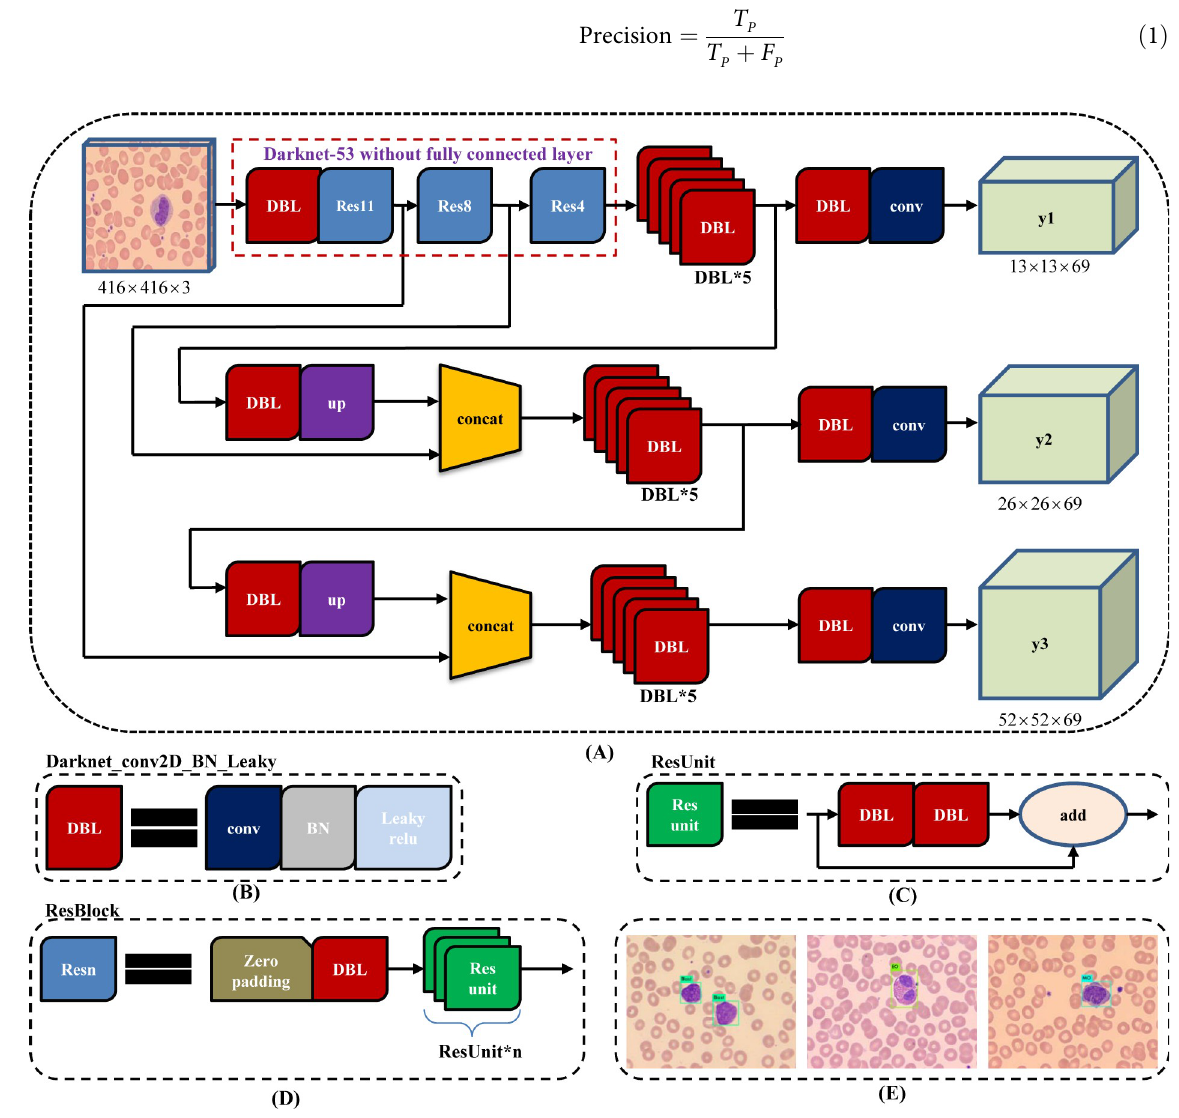
Fig 5. YOLOv3 architecture. (A) YOLOv3 pipeline with input image size 416 × 416 and 3 types of feature map (13 × 13 × 69, 26 × 26 × 69and 52 × 52 × 69)as output; (B) the basic element of YOLOv3, Darknet_conv2D_BN_Leaky ("DBL" for short), is composed of one convolution layer, one batch normalization layer and one leaky relu layer.; (C) two "DBL" structures following with one "add" layer leads to residual-like unit ("ResUnit" for short); (D) several "ResUnit" with one zero padding layer and "DBL" structure forward generates residual-like block, "ResBlock" for short, which is the module element of Darknet-53; (E) some detection results of peripheral leukocyte using YOLOv3 approach, resize the 732 × 574 images to 416 × 416 size as input.